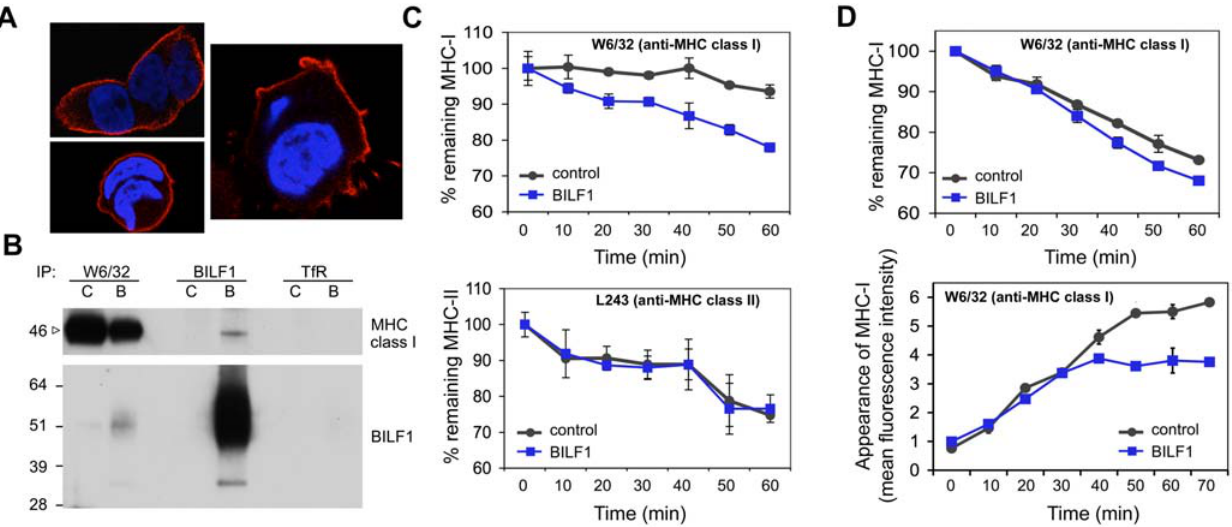
Figure 7. BILF1 associates with MHC class I molecules at the cell surface and increases their rate of internalization. ( A ) BILF1 is predominantly localized at the cell surface. 293 cells stably transduced with BILF1 retrovirus were grown on glass slides, fixed and permeabilized, then stained with rat anti-HA (3F10) primary antibodies and Alexa Fluor H 594 goat anti-rat IgG. The nuclei were counterstained with DAPI. The stained slides were analyzed with a laser scanning confocal microscope, and the three photographs show different 1 micron-thick sections through representative cells. BILF1 stained red, and the nuclei stained blue. ( B ) BILF1 and MHC class I molecules co-precipitate at the cell surface. 293 cells (2 6 10 6 ) stably transduced with control ( C ) or BILF1 ( B ) retrovirus were incubated with saturating concentrations of antibodies specific for MHC class I (W6/32), TfR (H68.4) or HA tagged BILF1 (3F10) on ice. After washing away excess antibody, the cells were lysed with NP40 detergent buffer, then precipitated with protein A/G beads and subjected to western-blotting as in Fig. 6B, using antibodies specific for MHC class I (HC10) and HA tagged BILF1 (3F10). ( C ) BILF1 increases the rate of internalization of MHC class I, but not class II, from the cell surface. MJS cells stably transduced with control or BILF1 retrovirus were incubated at 0 u C with saturating concentrations of mAb to MHC class I (W6/32; top graph) or MHC class II (L234; bottom graph), then washed and incubated at 37 u C for different periods of time. The cells were subsequently stained with PE-conjugated goat anti- mouse IgG antibody, and analyzed by flow cytometry. The mean fluorescence intensities of staining were averaged for triplicate samples, and normalized to the initial time 0 min samples. ( D ) BILF1 increases the rate of internalization, but not the rate of appearance, of MHC class I at the cell surface. Top graph: 293 cells stably transduced with control or BILF1 retrovirus were incubated at 0 u C with saturating concentrations of mAb to MHC class I (W6/32), then treated exactly as for the internalization assay performed with MJS cells in panel C. Bottom graph: replicate aliquots of the saturated W6/32-bound cells were harvested at the indicated time points, and the appearance of new MHC class I molecules was assayed by staining with PE-conjugated W6/32 antibody. The mean fluorescence intensities of staining were averaged for triplicate samples.